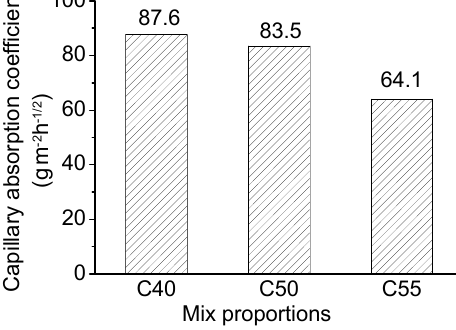
Figure 6. Capillary absorption coefficients of C40, C50, and C55.